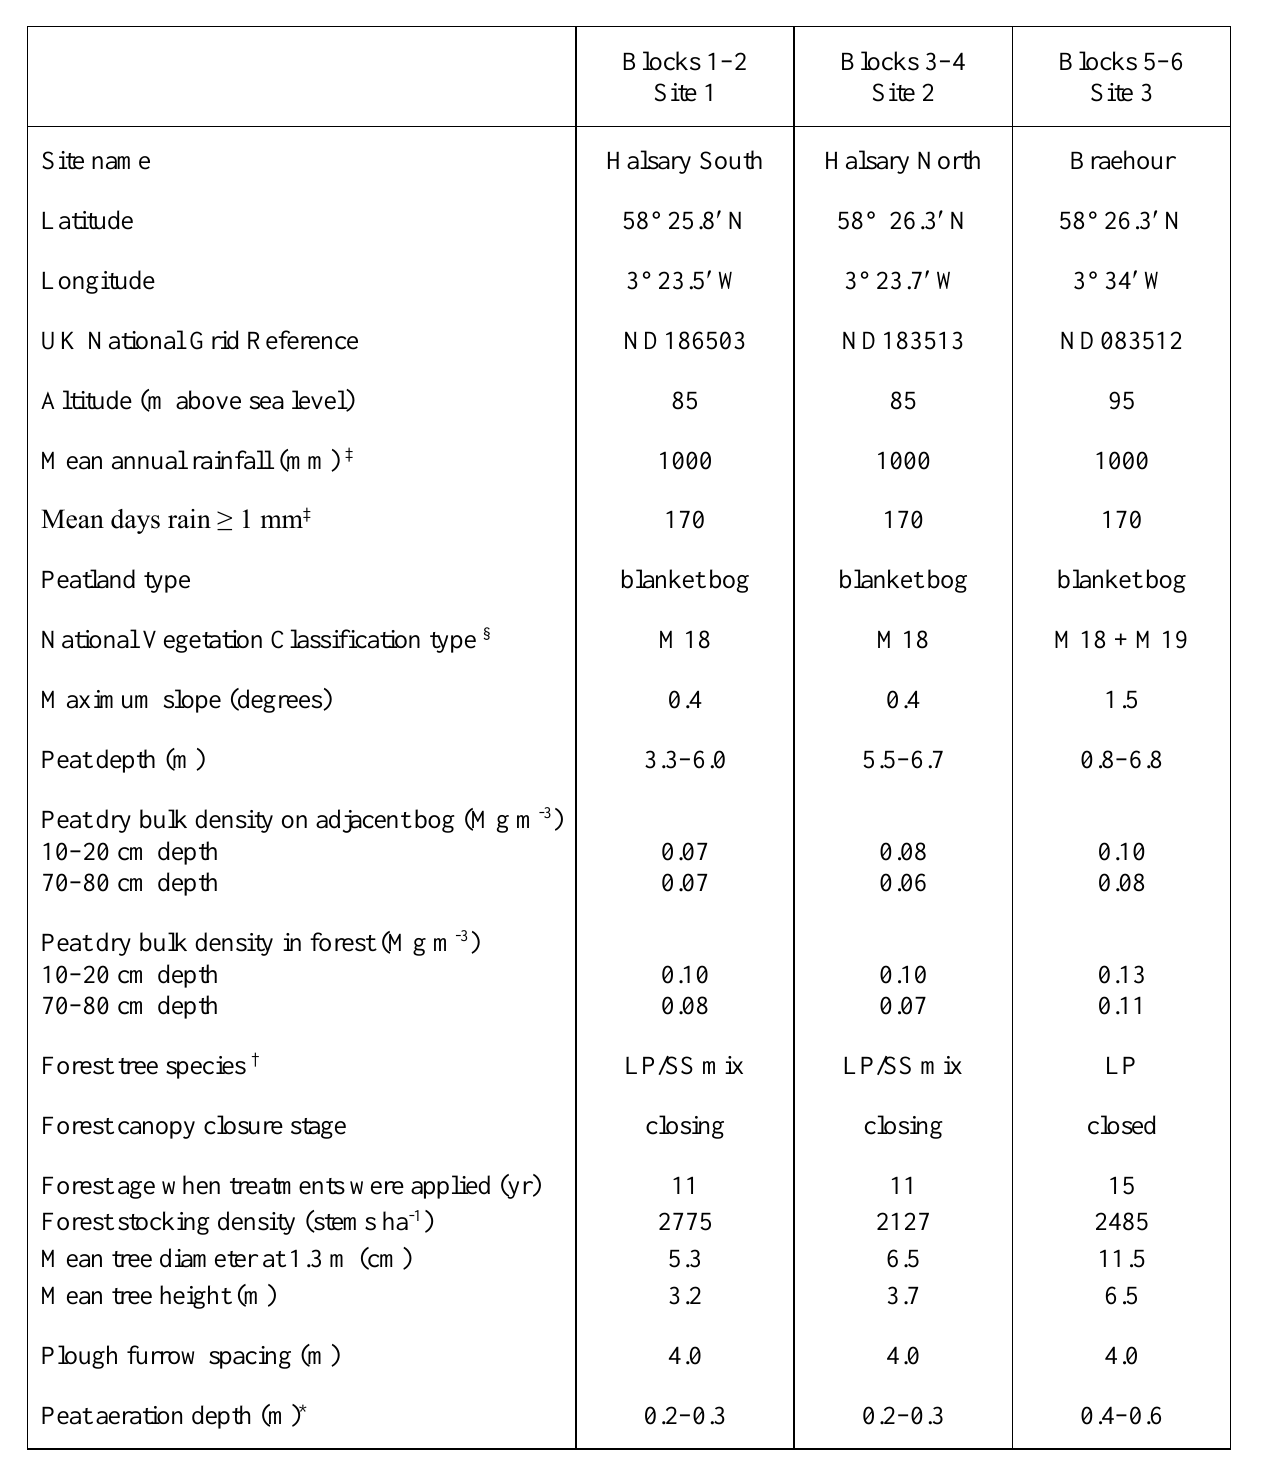
Table 1. Experiment site